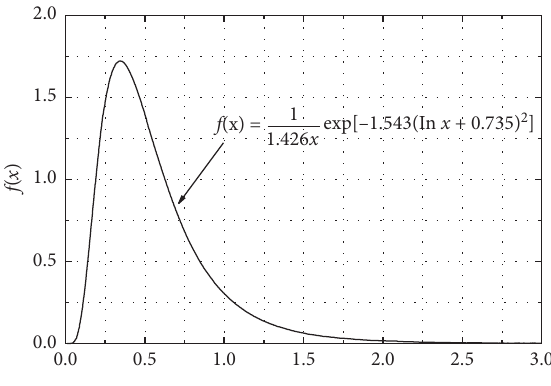
Figure 1: Probability density function curve.